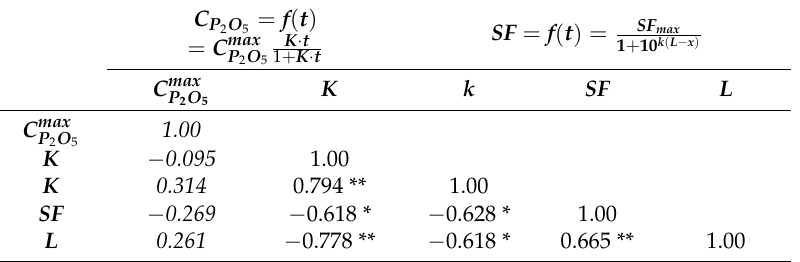
= f ( t ) C P 2 O 5 = C